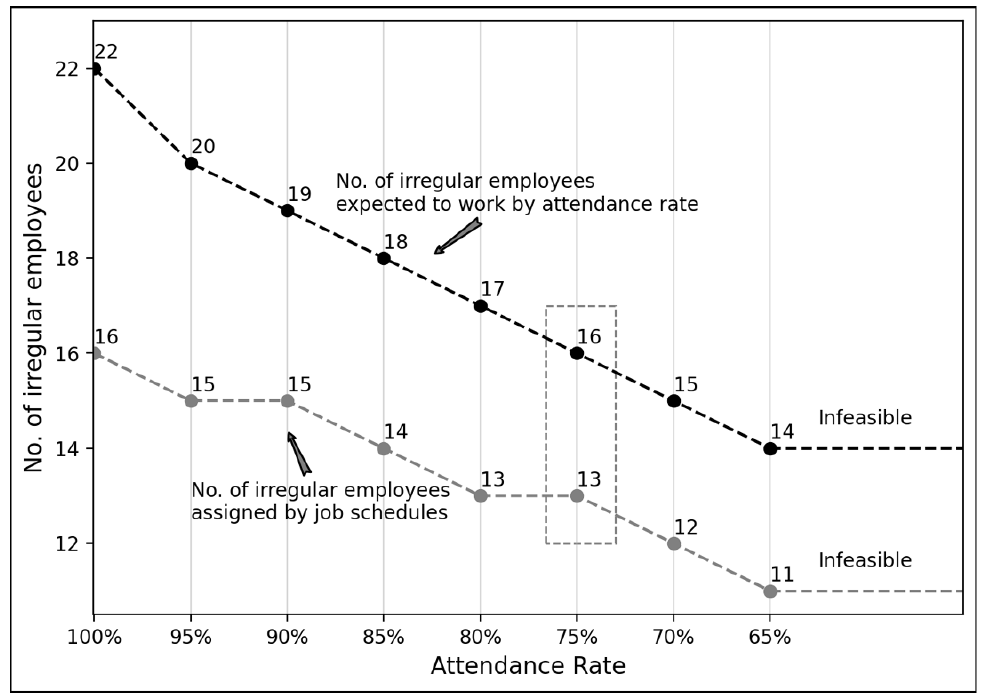
Figure 7. The difference between an expected number and the assigned number of irregular em- ployees depending on attendance rate (the percent of irregular employees’ absences). ees depending on attendance rate (the percent of irregular employees’